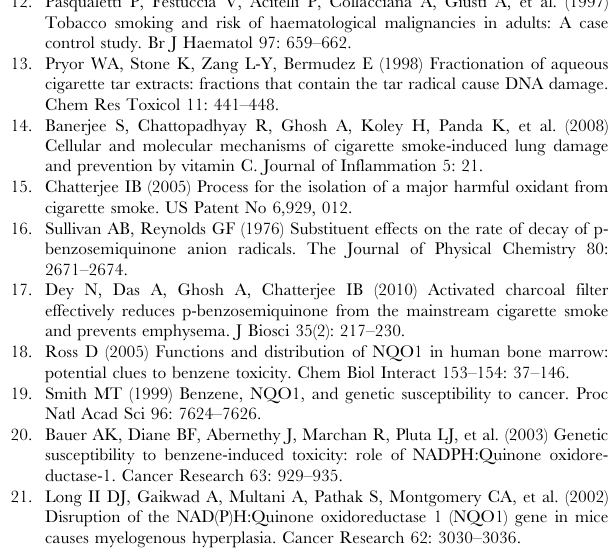
Figure S2 Differential staining of bone marrow cells showing myeloid hyperplasia and hypercellularity in MDS guinea pigs. (Panel A) Bone marrow aspirates showing myeloid hyperplasia; magnification 200 6 . (Panel B) Bone marrow histology showing hypercellularity; magnification 400 6 . Vit C means vitamin C. (TIF) Figure S3 Signal transduction and cell cycle analyses in MDS guinea pig at different periods. (Panel A) EGFR was immunoprecipitated (IP) with anti-EGFR and the precipitated proteins were immunoblotted (IB) with anti-phospho-Try (PY20) and anti-EGFR. (Panel B) Immunoblots of HRAS + KRAS, ERK1/2, p-ERK1/2, c-Myc, p-c-Myc, Akt and p-Akt.; p-EGFR, phospho-EGFR; p-ERK1/2, phospho-ERK1/2; p-c-Myc, phos- pho- c-Myc; p-Akt, phospho-Akt. (Panel C) Cell cycle analyses of bone marrow by flow cytometry: Y-axis, cell counts; X-axis PI stain. M1 represents G0/1; M2, S; M3, G2/M- phase. Vit C means vitamin C. (TIF) Table S1 Peripheral blood cell count of different treated male guinea pigs. Table S2 Myeloid and Nonmyeloid cell ratio in bone marrow.